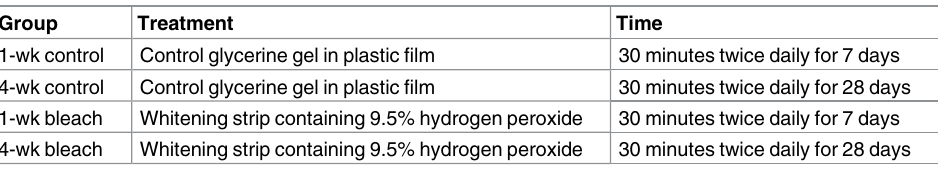
Table 2. Outline of test groups.